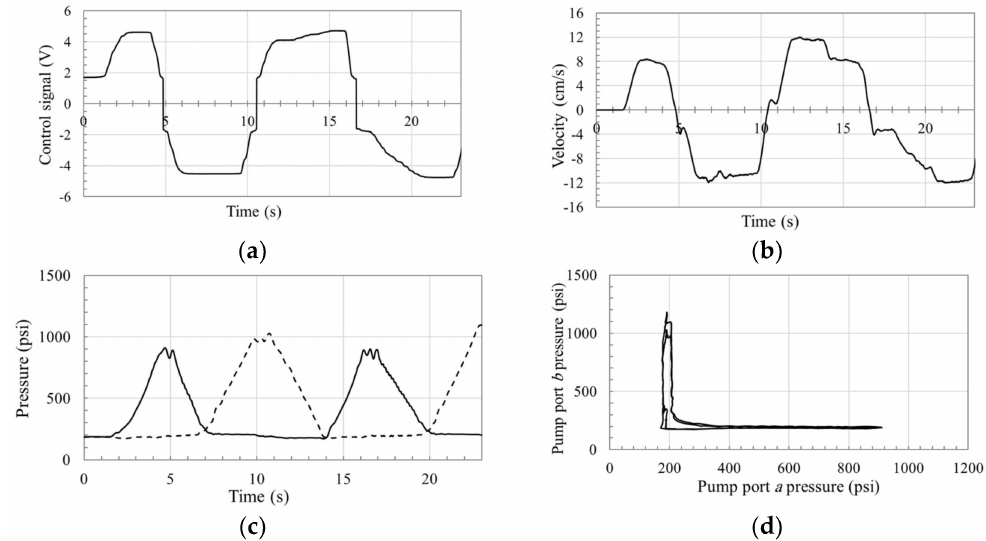
Figure 20. Performance of circuit with SQVs for a 368 kg attached mass: ( a ) joystick input control signal; ( b ) actuator velocity; ( c ) pressures at the pump ports a (solid line) and b (dotted line); ( d ) pump pressure plane.